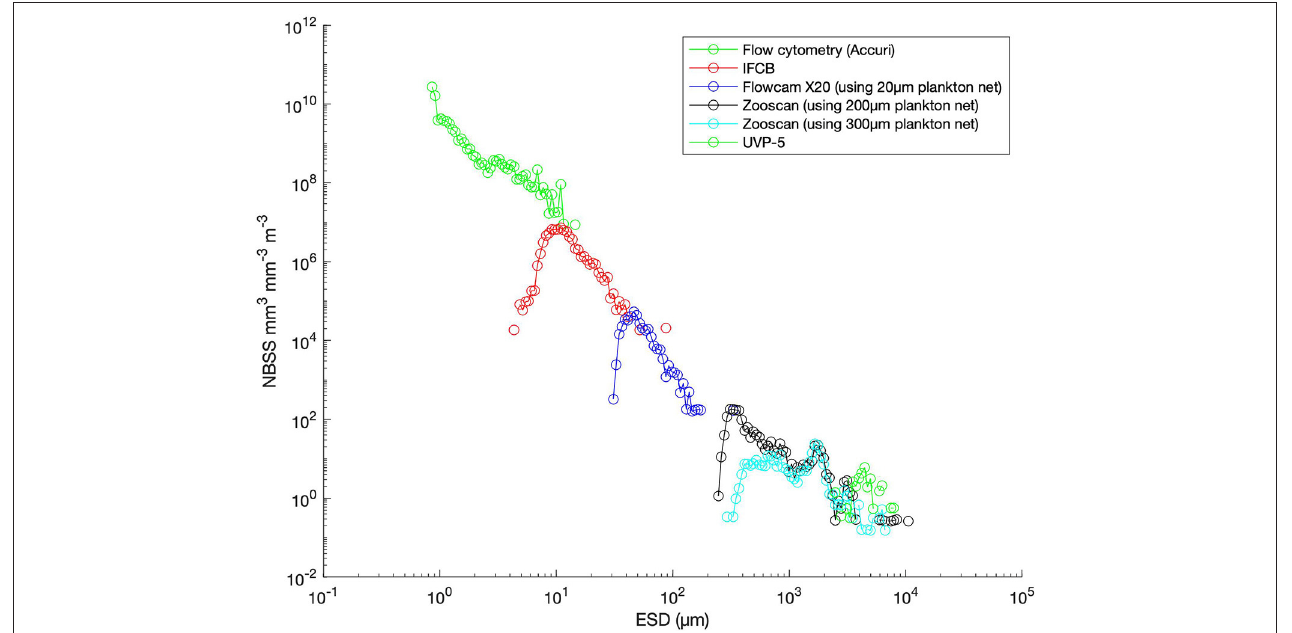
FIGURE 2 | Comparison of total planktonic organisms sampled with different collection methods and analyzed with different optical/imaging methods as a function of the size of organisms (expressed as equivalent spherical diameter; ESD). All sampling was done at the same station during Tara-Ocean Cruise at station 210 (Labrador Sea). Total organism biovolume per size classes were expressed as normalized biovolume size spectra (NBSS) by dividing the total biovolume within a size class by the biovolume interval of the considered size class. NBSS is representative of the number of organisms within a size class. Results were obtained by analyzing whole water with optical method (using an Accuri Flowcytometer) and imaging methods (Imaging FlowCyto Bot-IFCB and Underwater Vision Profiler UVP-5) and plankton net samples of various mesh sizes using imaging methods (Flowcam with a 20X lens and Zooscan). All data are raw counts (removing only objects determined to be not living) and converted to biovolume using elipsoidal calculations. The low count at the smaller size range of each observation corresponds to an underestimation of an object’s number due to both limited capabilities of each imaging device for small objects and net undersampling for small